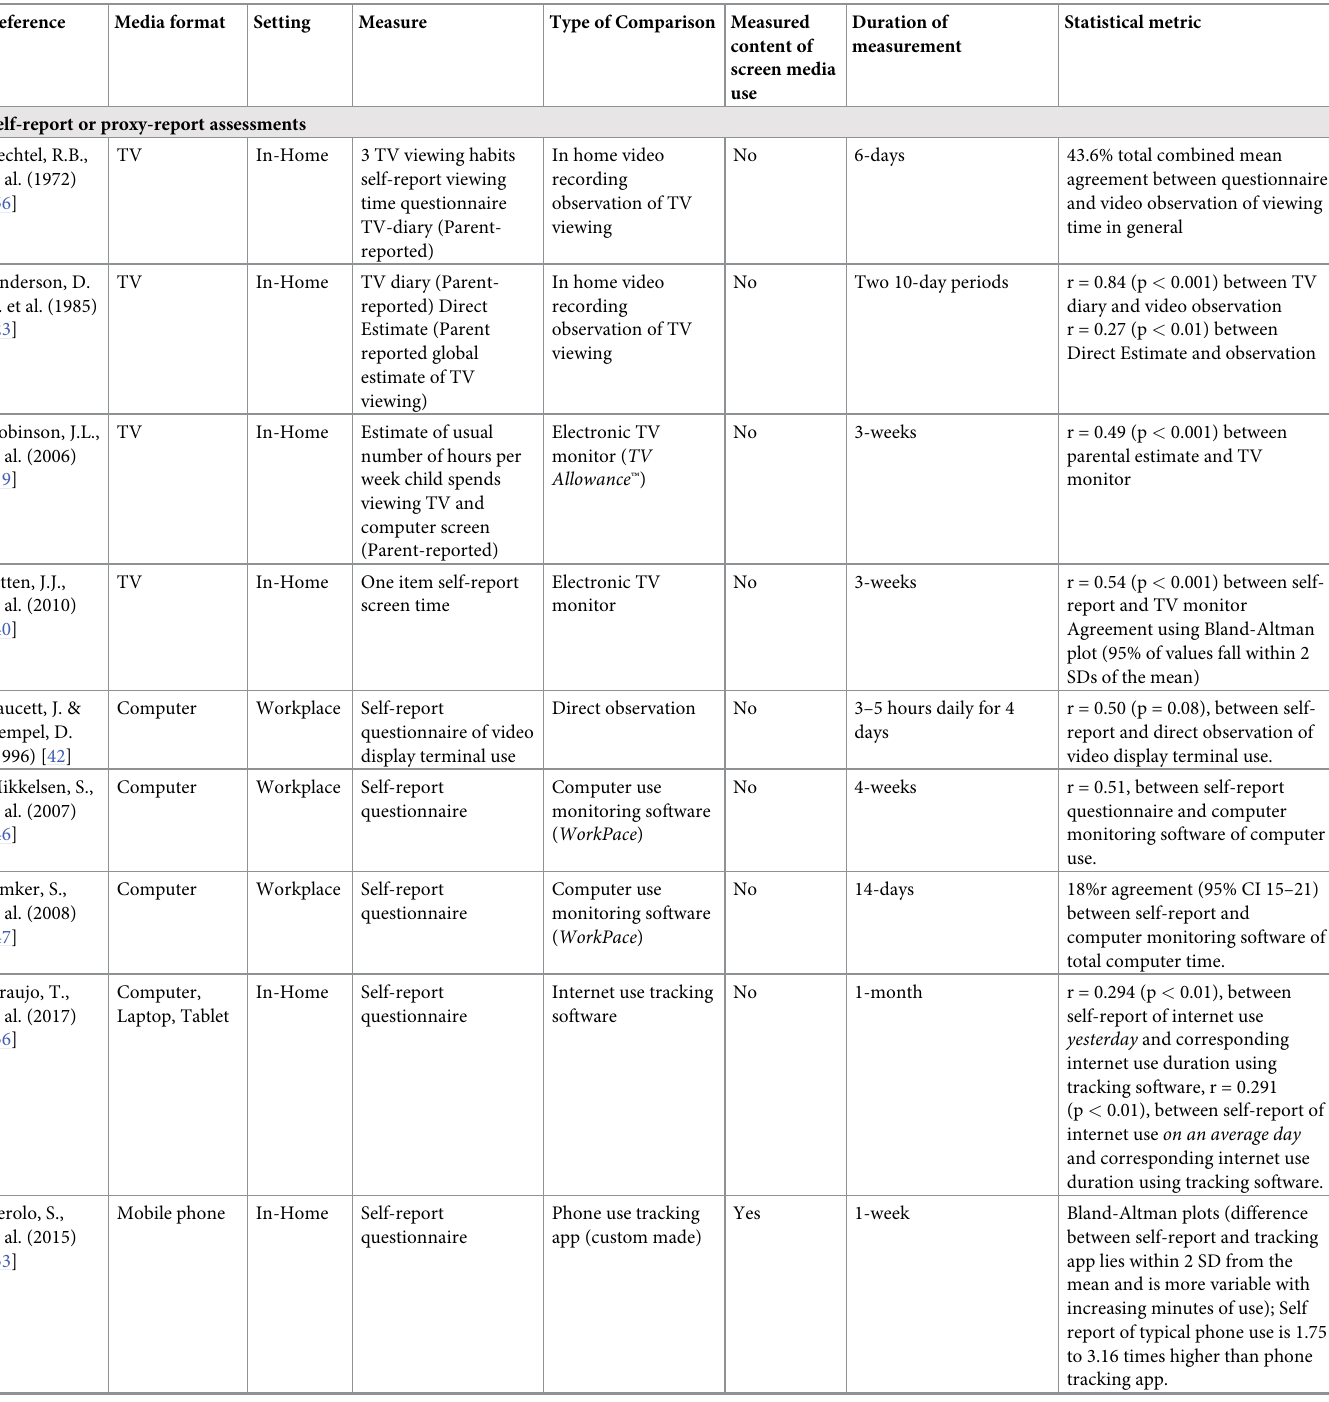
Table 2. Screen media use assessment tools validated against gold standard, by type of